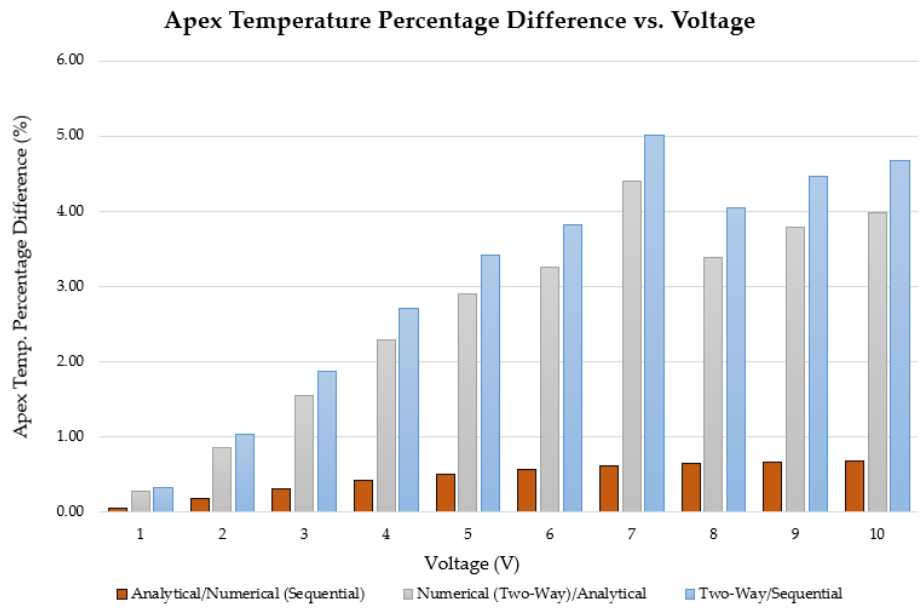
Figure 9. Percentage difference comparison of maximum apex temperatures as obtained via analytical and numerical methodologies. Results from all three methods were compared with one another.